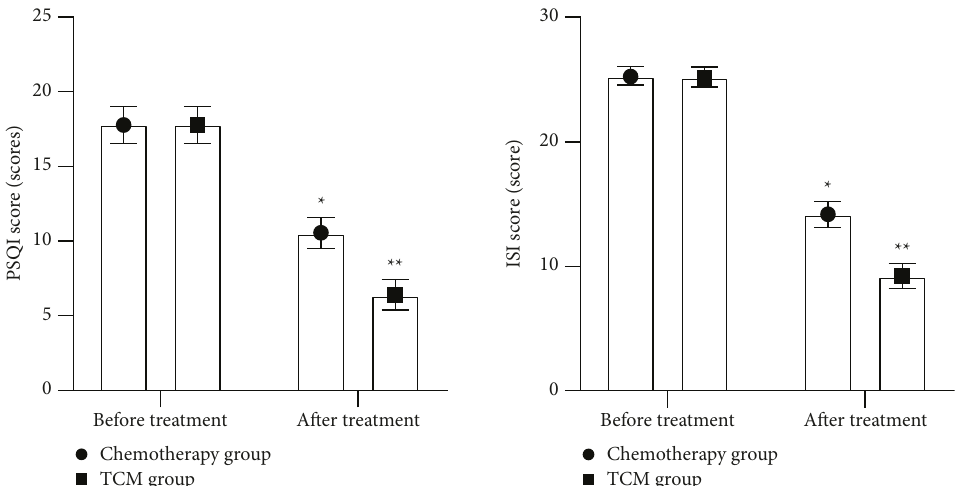
Figure 2: Comparison of immune function indicators between the two groups. Note: compared with the chemotherapy group before treatment, ∗ P < 0 . 05; compared with the TCM group before treatment and the chemotherapy group after treatment, ∗∗ P < 0 . 05.